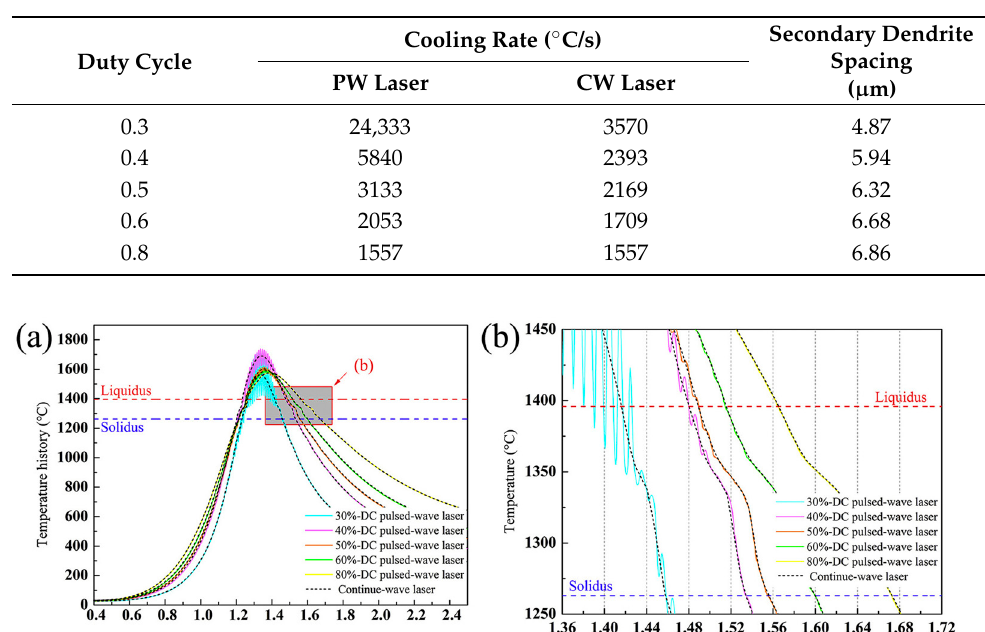
Table 2. Cooling rate around 1370 ◦ C and dendrite spacing of K447A alloy deposition [33]. Duty Cycle 0.3